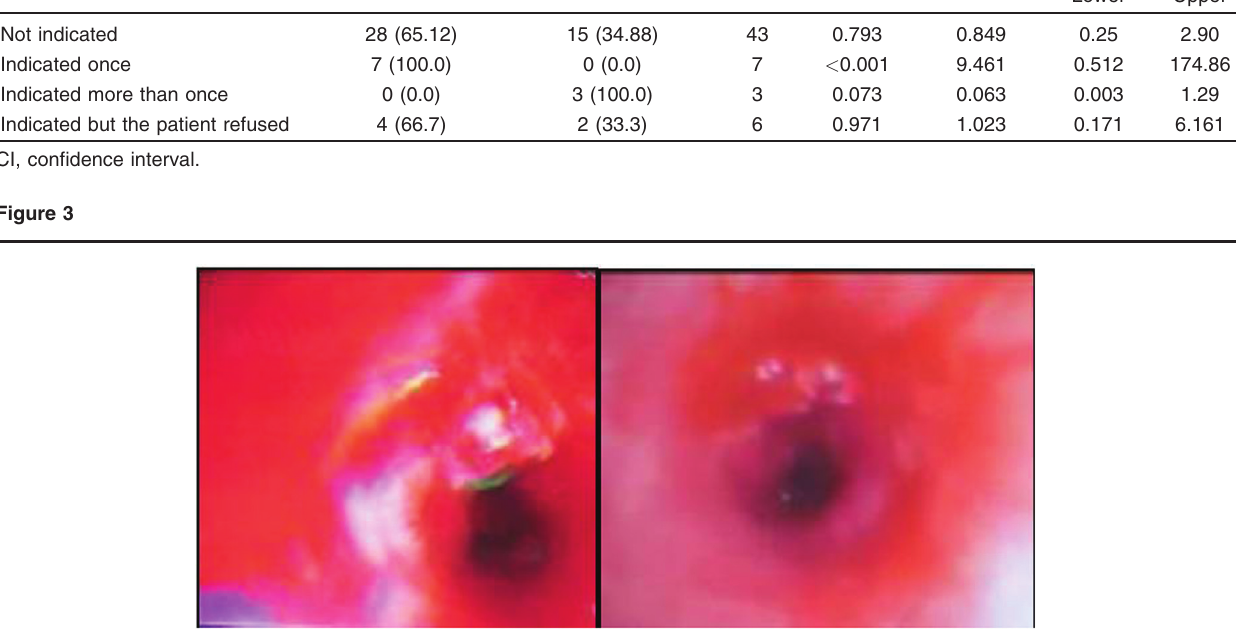
Granulation tissue in bronchus intermedius surrounded with purulent secretions after removal of the foreign